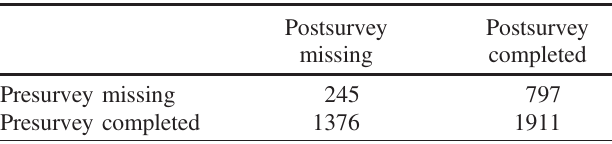
TABLE XI. Number of PLIC closed-response pre- and post- surveys collected.